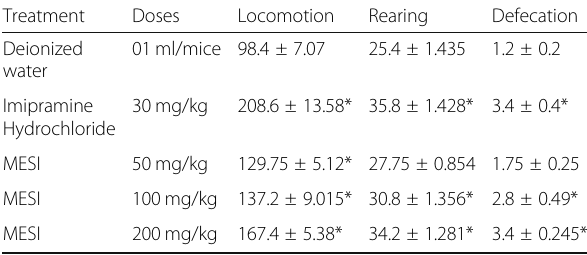
Table 3 Effect of MESI in